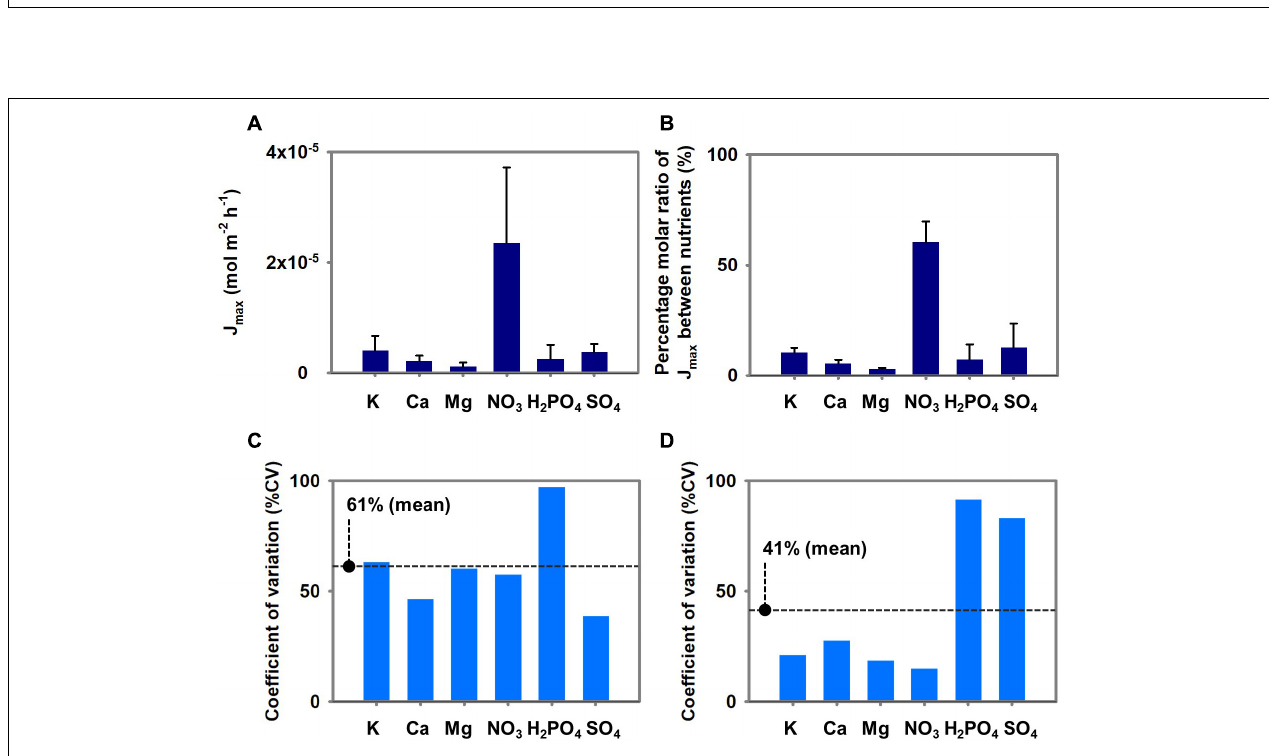
FIGURE 7 | (A) Mean ± SD of J max of three Brassica species (pakchoi, lacinato kale, and curly kale). (B) Percentage molar ratio between J max of the nutrients. (C) The percent coefficient of variation among the J max of three Brassica species. (D) The percent coefficient of variation among the percentage molar ratio between J max of the